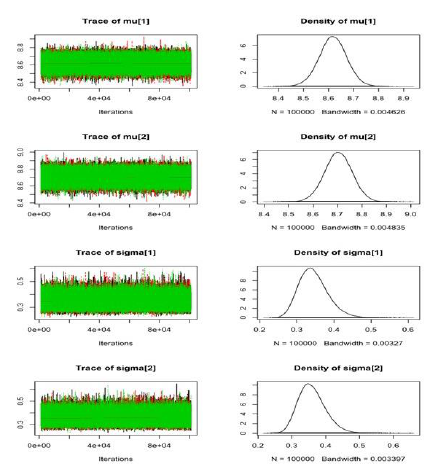
Fig. 5. Trace plots for mean log AUC 0-12 MCMC convergence diagnostics